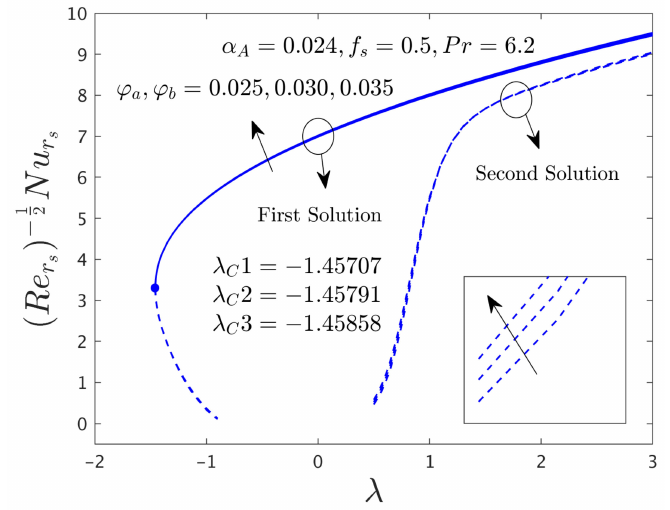
Figure 13. Variations of Re 0.5 r